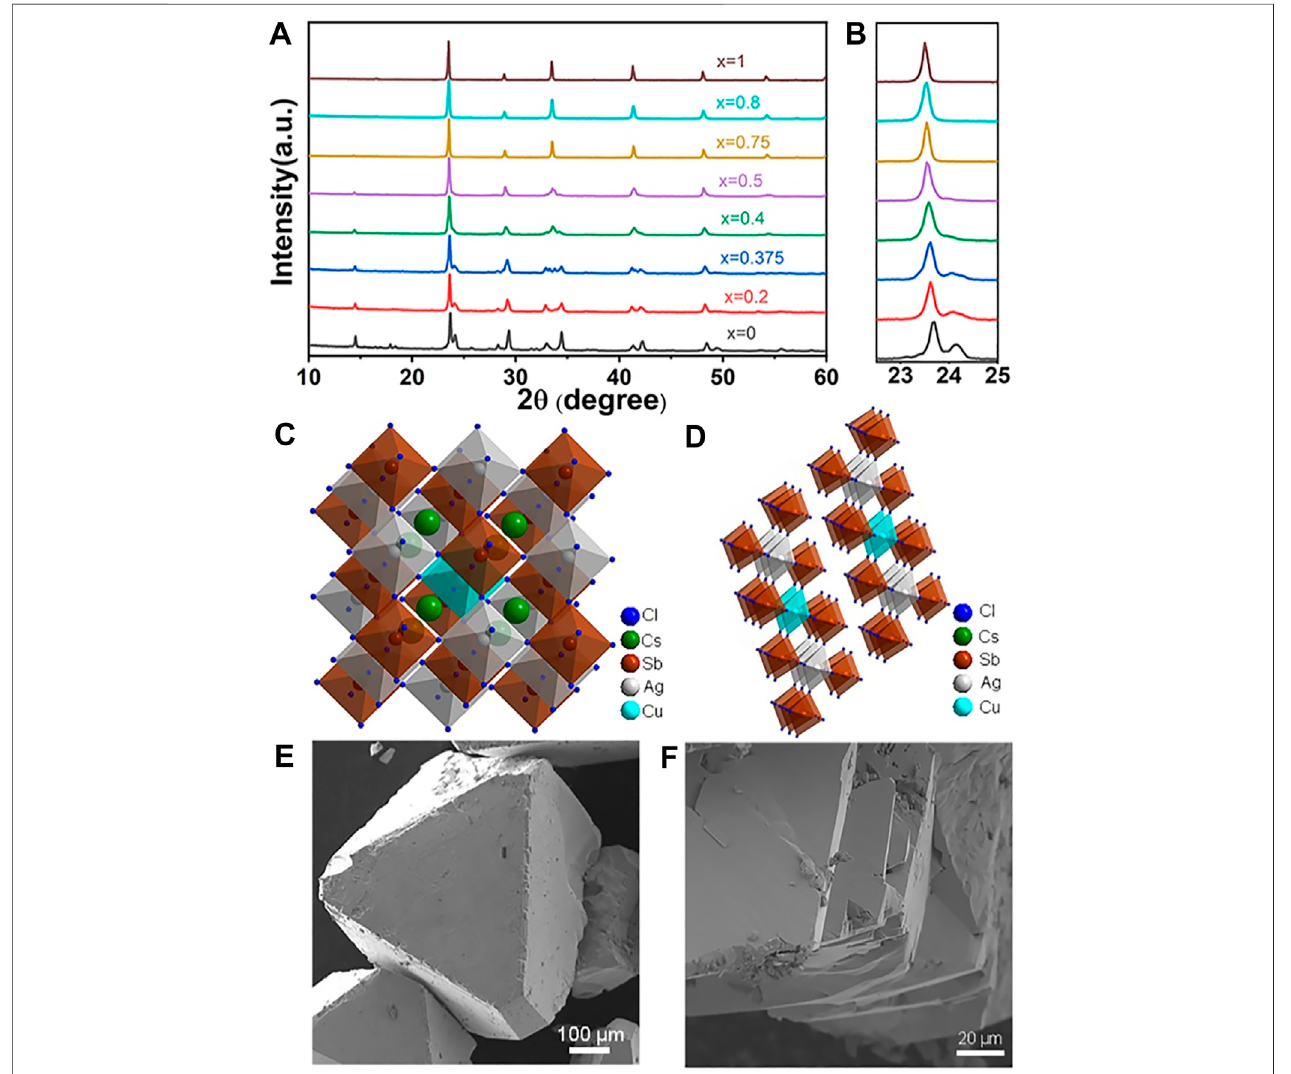
FIGURE 1 | (A) XRD patterns of Cs 4 Cu 1-x Ag 2x Sb 2 Cl 12 (x = 0, 0.2, 0.25, 0.4, 0.5, 0.75, 0.8, 1). (B) Magni fi ed images of (022) diffraction peaks. (C,D) Crystal structures of